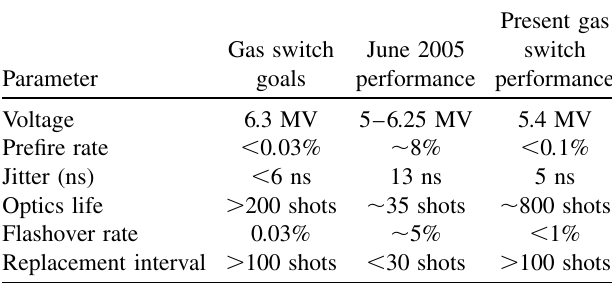
TABLE I. Goals, requirements, and switch performance at 5.4 MV for the LTGS developed for the refurbished Z accelera-